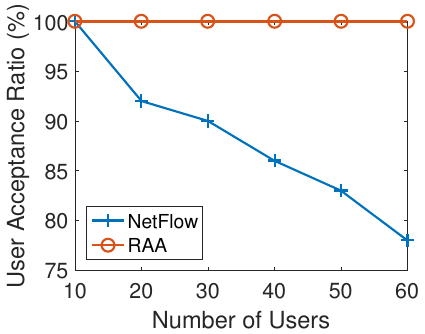
Figure 10. User acceptance ratio for varied numbers of users with 20